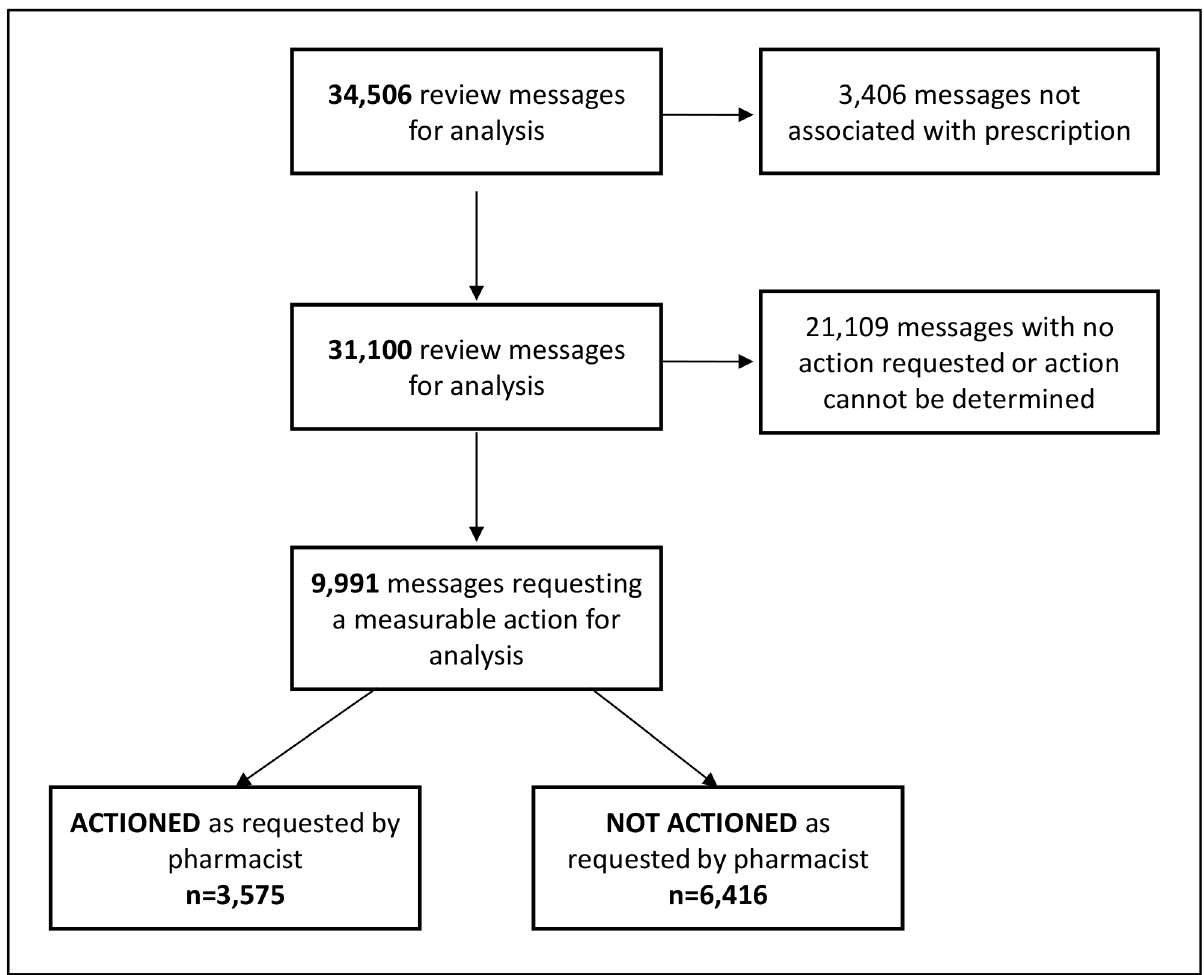
Fig 3. Review messages taken forward for analysis of